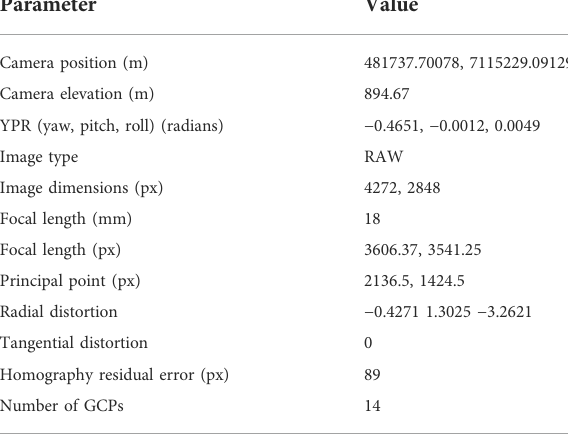
TABLE 1 Time-lapse camera settings and